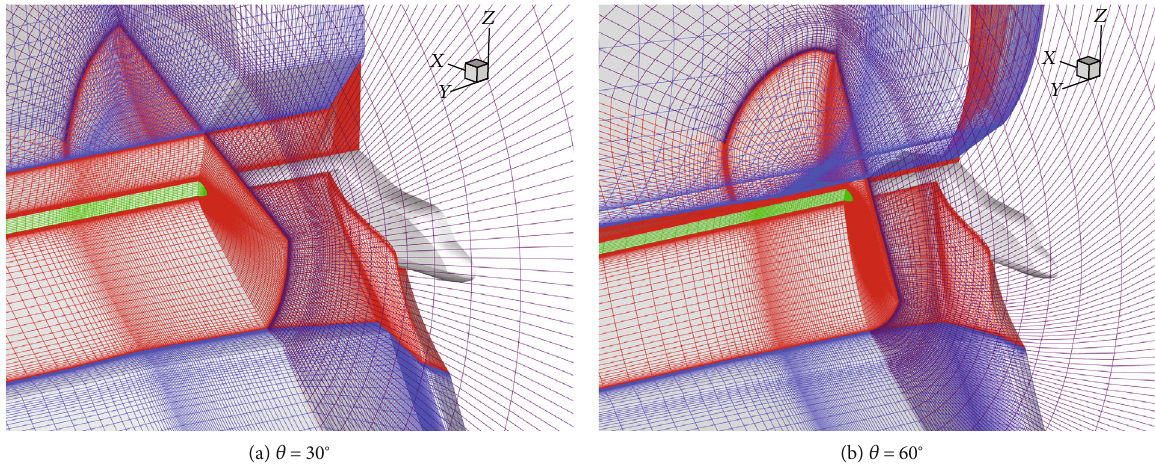
Figure 10: Dynamic meshes using the present method.